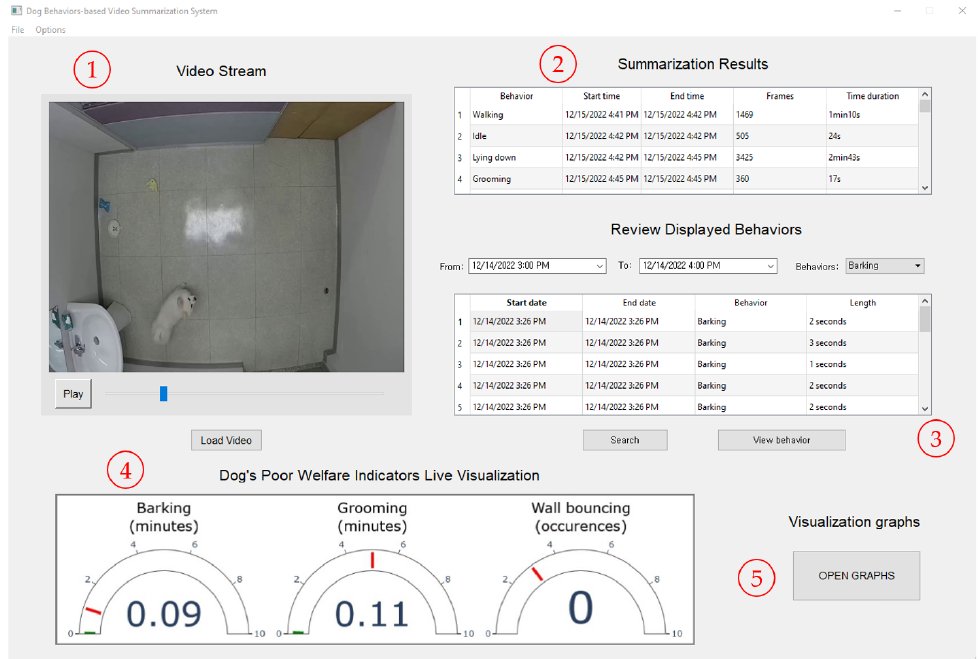
Figure 12. Screenshot of the main interface of the proposed system: (1) controls to load and start processing a video stream; (2) table displaying the behaviors summarization results; (3) controls to search for logged dog behaviors and rewatch them; (4) live display of the visualization of dog’s poor-welfare indicators; (5) button to open the visualization graphs interface shown in Figure 13.